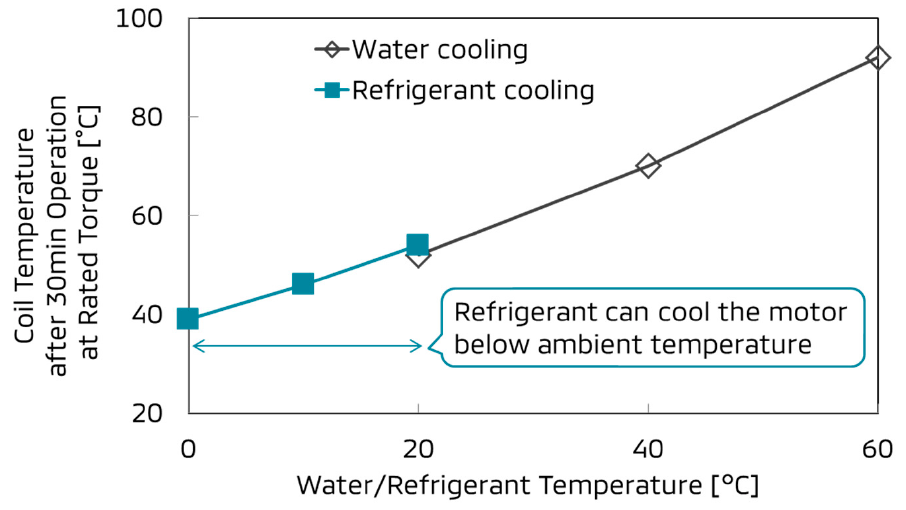
Figure 6. Coil temperature after 30 min operation at rated torque vs water temperature or refrigerant temperature.